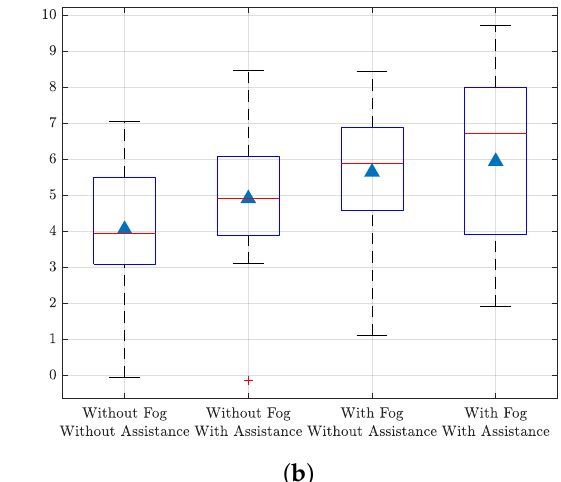
Figure 10. Parameters obtained from system identification: ( a ) identified anticipatory gain ( K p ) and ( b ) identified compensatory gain ( K c